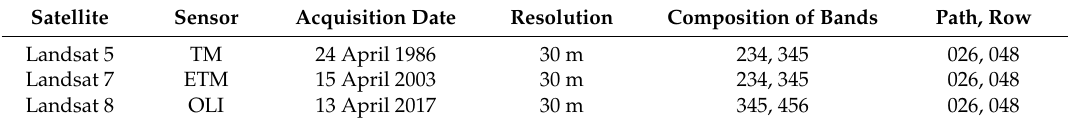
Table 2. Acquired Landsat images [62].